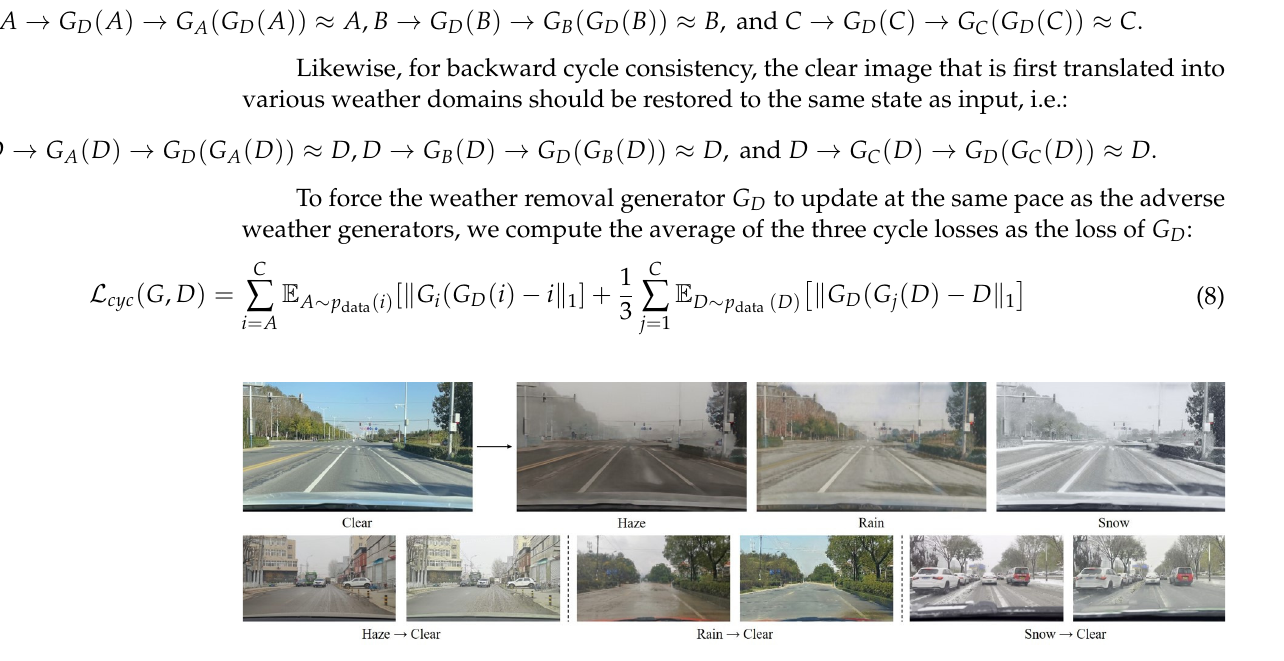
Figure 2. MWTG translates clear images into hazy, rainy, or snowy images using three different generators, creating a set of images representing different weather conditions (top row). In contrast, only one generator is needed to translate all three types of adverse weather images into clear ones (bottom